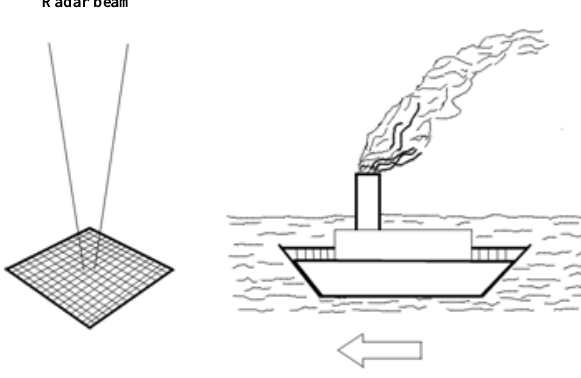
Figure 4. Cartoon showing how a slit camera would view the plume from a boat moving east into a velocity